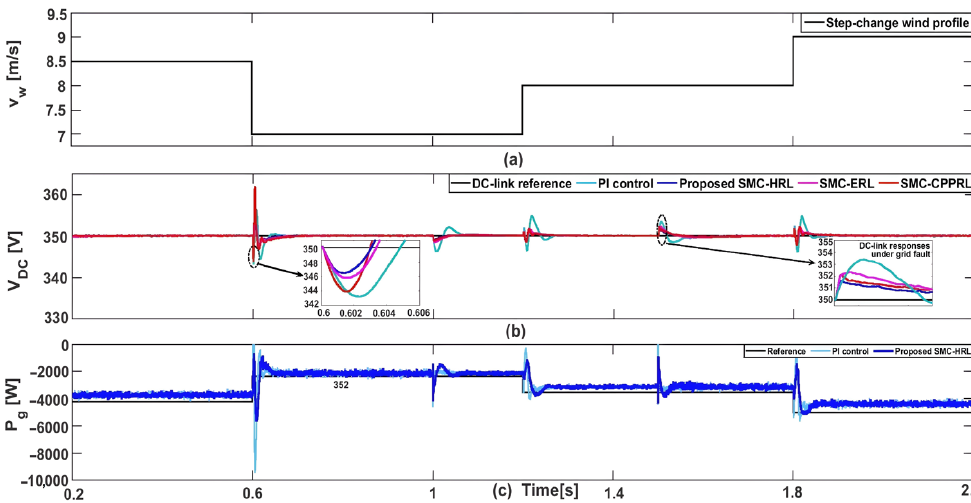
Figure 5. Simulation responses of DC-link voltage for step-change wind speed and grid-side fault. ( a ) Wind speed. ( b ) DC-link voltage. ( c ) Grid-side active